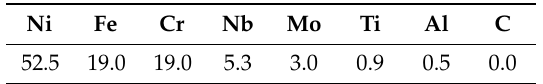
Table 1. Chemical composition in mass percentage of the Inconel